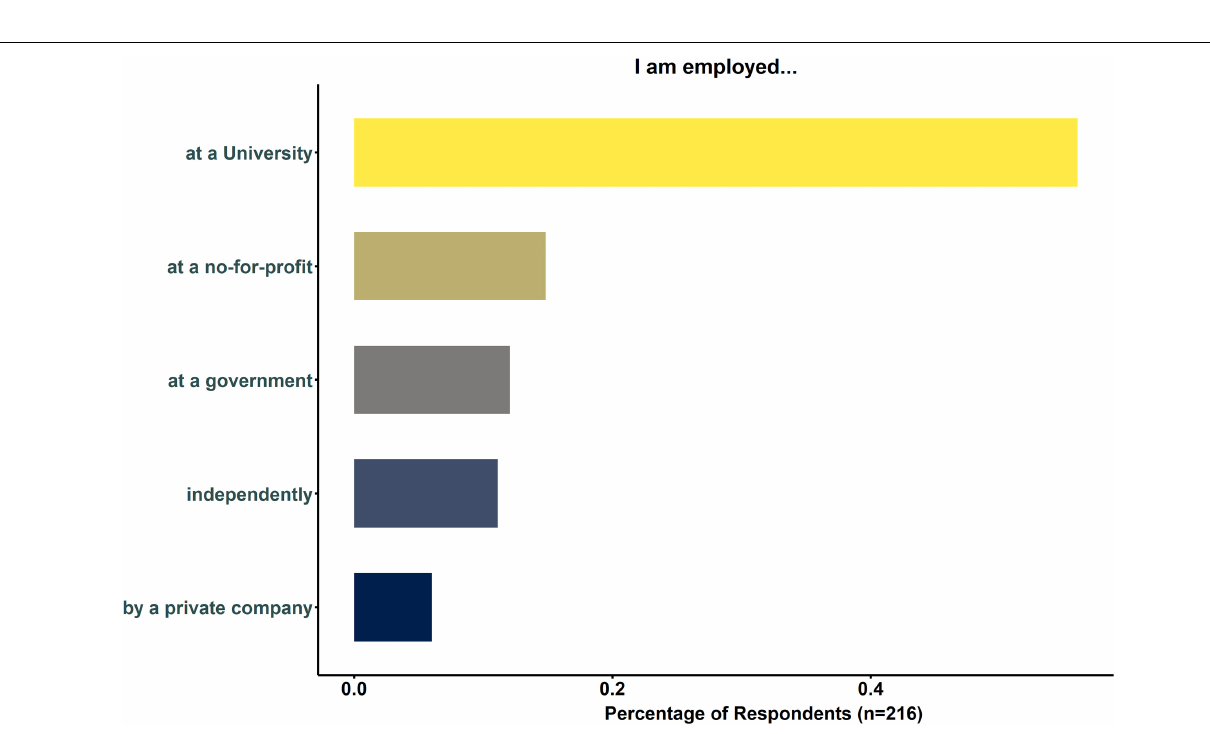
FIGURE 2 | Place of employment of respondents to an online survey about conducting research and management in the arboreal ecosystem ( n = 216). Each respondent could only choose one option.